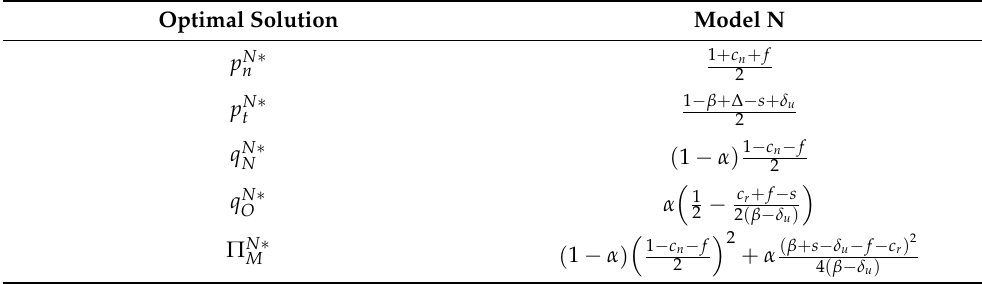
Table 4. Monotonicity of q N ∗